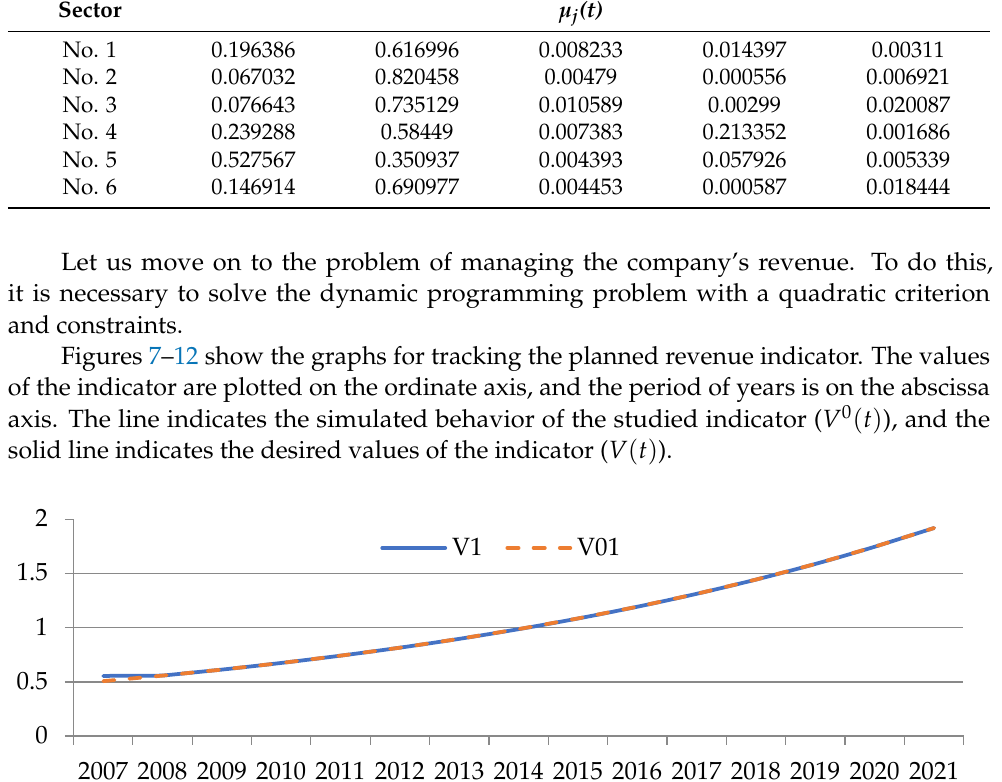
Figure 8. Graphs for tracking the target revenue indicator for industry No. 2 (author’s results). Figure 9. Graphs for tracking the target revenue indicator for industry No. 3 (author’s results). Figure 10. Graphs for tracking the target revenue indicator for industry No. 4 (author’s results).